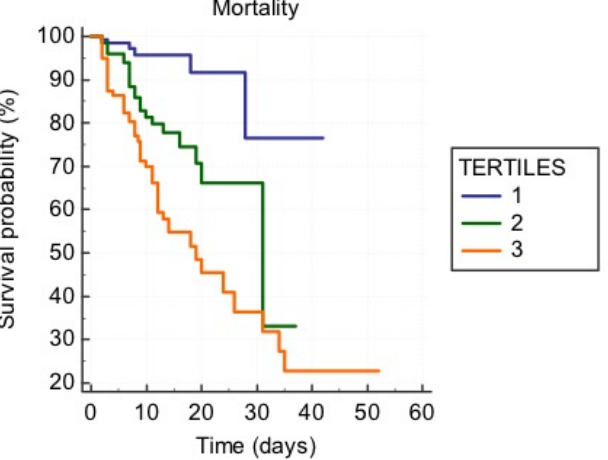
Figure 3. Kaplan–Meier curve showing survival probability according to NLR tertiles. (1st NLR tertile = 0.9–6.83; 2nd NLR tertile = 6.89–14.02; 3rd NLR tertile = 14.1–98).